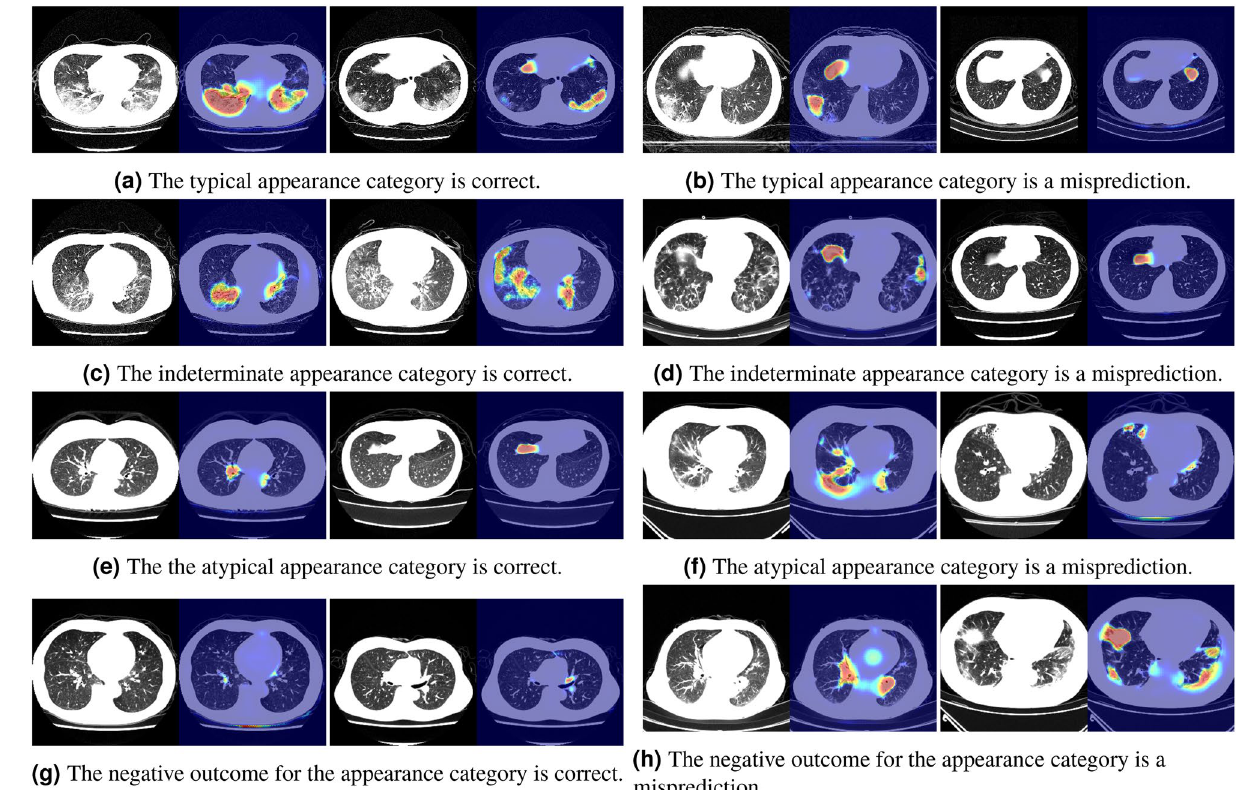
Figure 8. Results of visual explanations for four-class classification. ( a , c , e , g ) Results when the predictions are correct. ( b , d , f , h ) Results when the predictions are